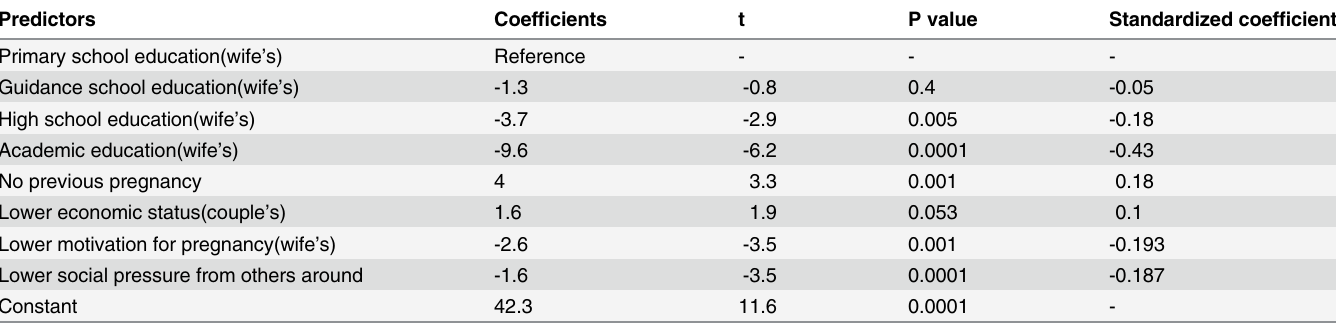
Table 2. Multivariate regression results predicting irrational parenthood cognition score based on robust standard